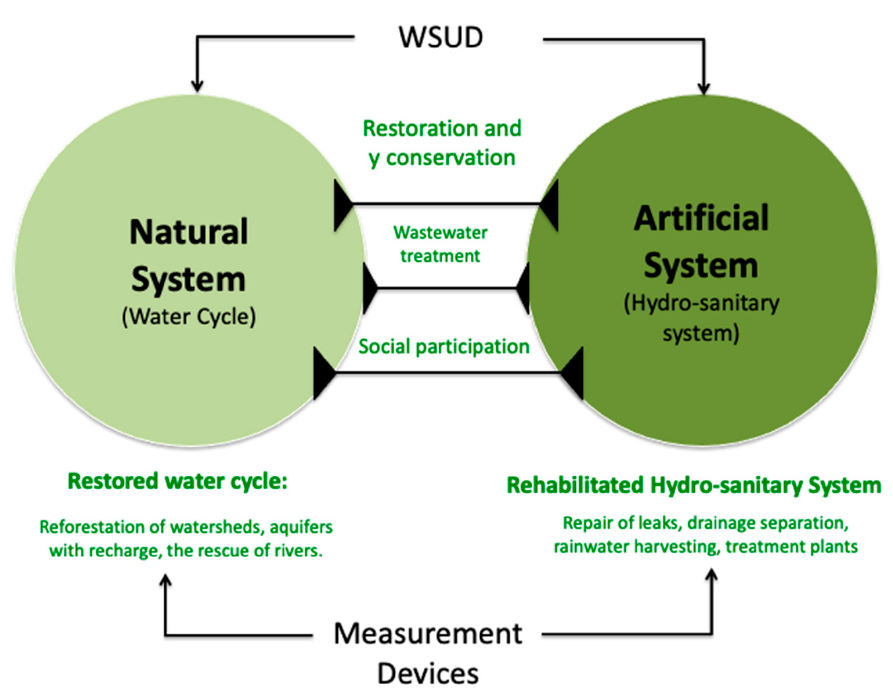
Figure 7. Integration of natural and artificial system.